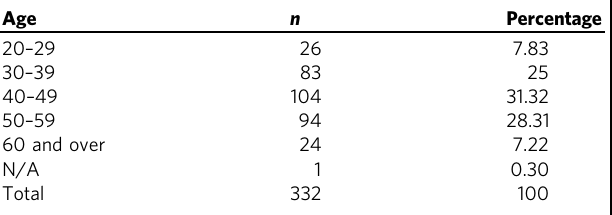
Table 1 Age ranges of the